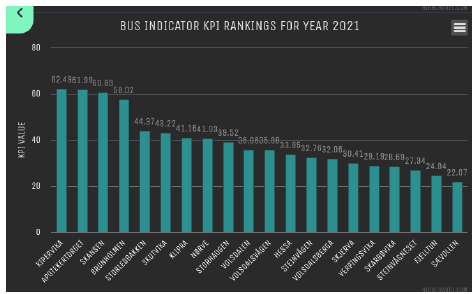
Figure 13. Comparison between all the